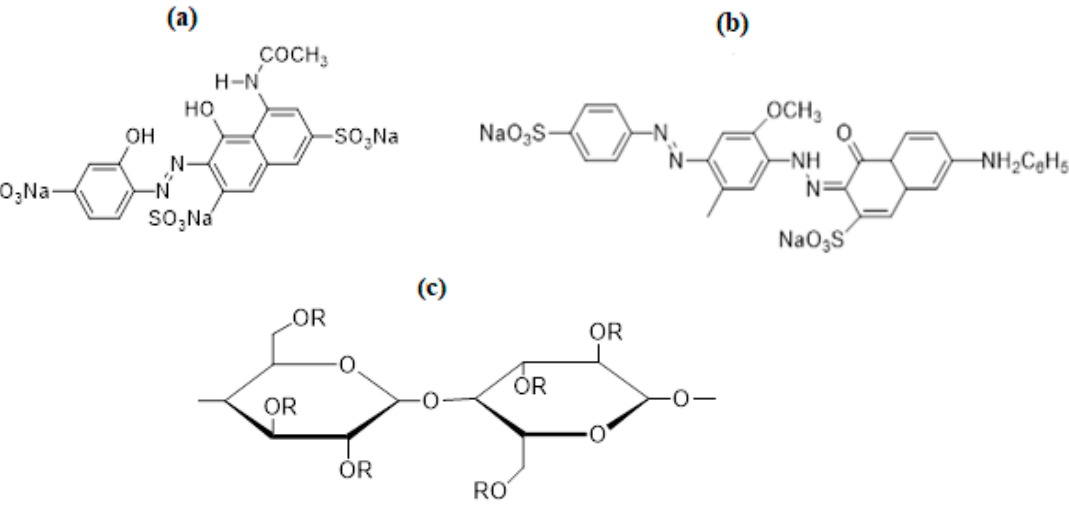
Figure 1. Structure of ( a ) Reactive Violet 5, ( b ) Direct Violet 9, and ( c ) functional unit of cotton.